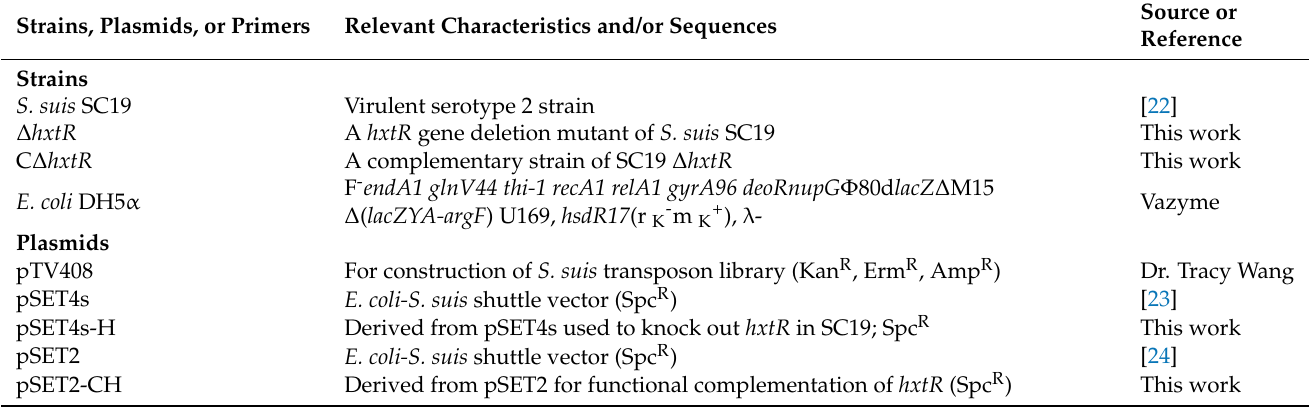
Table 1. Bacterial strains, plasmids, and primers used in this